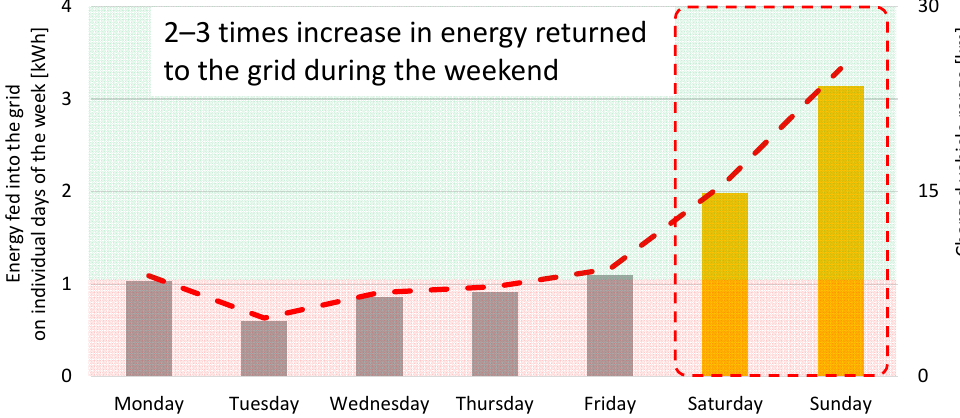
Figure 24. Range of EV charged in 100% from RES.